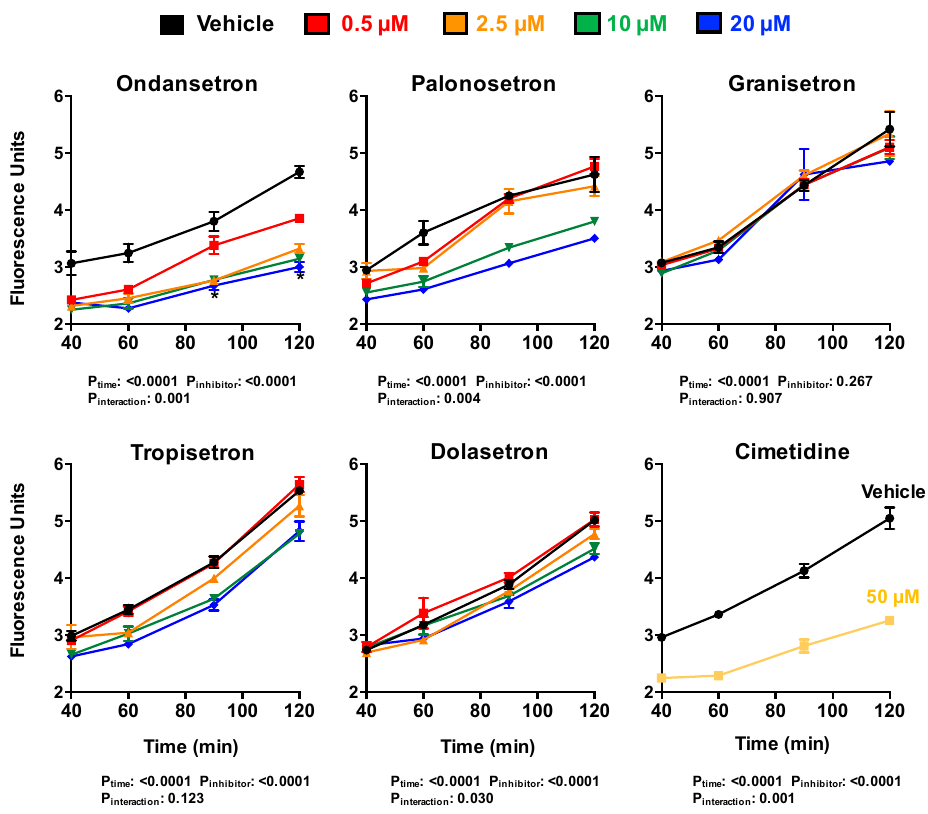
Figure 5. 5-HT 3 Antagonist Inhibition of ASP + Transepithelial Transport in OCT2/MATE1-Transfected MDCK Cells. Cells were incubated with ASP + (25 μ M) in basolateral media and/or 5-HT 3 antagonists (0.5–20 μ M) or 50 μ M cimetidine in apical and basolateral media for 120 min. Apical fluorescence was quantified between 40–120 min. Data are expressed as mean ± SE ( n = 3). Two-way ANOVA analyses evaluated the influence of time and inhibitor on ASP + transport.